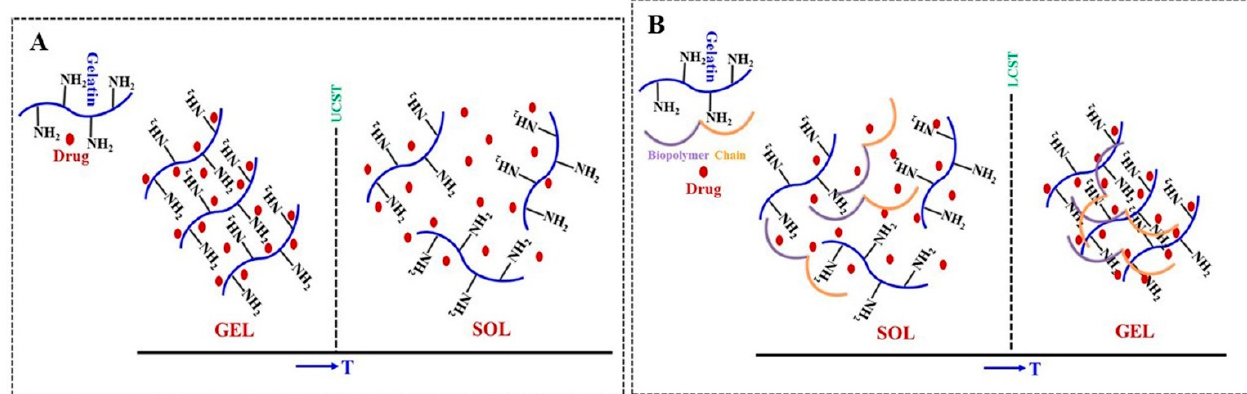
Figure 5. ( A ) UCST-type sol–gel transition of drug-loaded hydrogel system of gelatin; and ( B ) LCST-type sol–gel transition of drug-loaded hydrogel system of physically blended gelatin and other biopolymer (Schematic presentation).